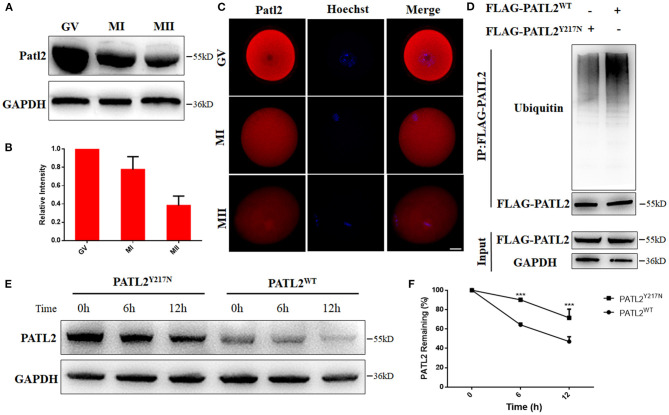
Effects of Y217N variants on PATL2 degradation. (A,B) The Patl2 levels in oocytes at germinal vesicle (GV), meiosis metaphase I (MI), and meiosis metaphase II (MII) stages were determined by western blot. (C) Immunostaining of Patl2 in oocytes at GV, MI, and MII stages. Scale bar, 20 μm. (D) Ubiquitination was evaluated by co-IP with an anti-FLAG antibody. (E,F) The PATL2 stability comparison between group of PATL2WT or PATL2Y217N transfected cells is followed by CHX treatment. ***p < 0.001.